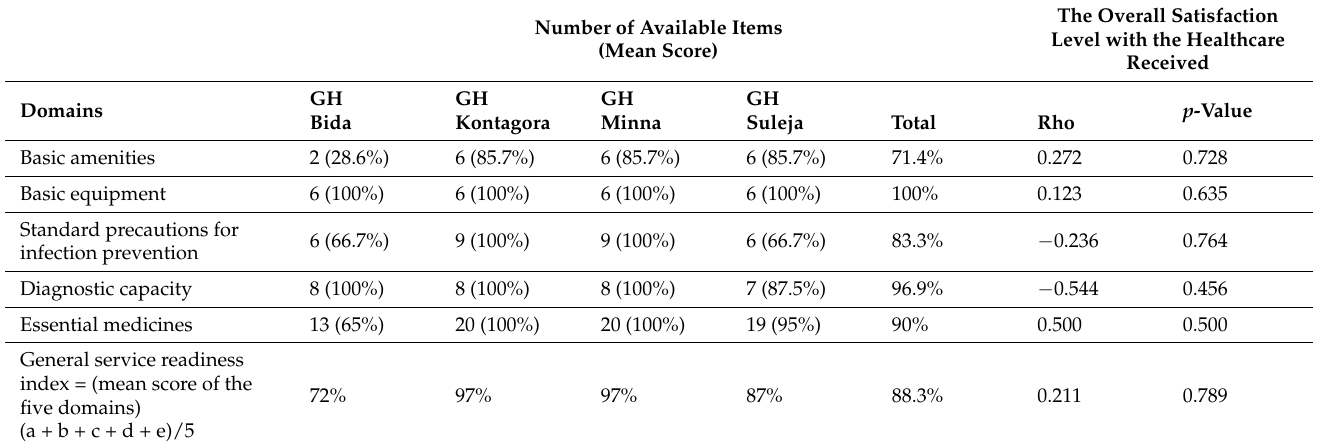
Table 2. Mean availability of items by domain score and satisfaction level with the healthcare received and facility